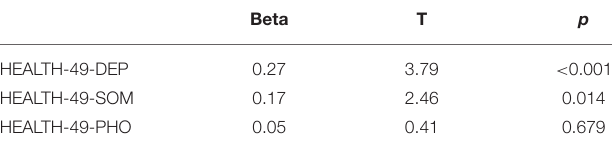
TABLE 5 | Multiple regression for prediction of TPA-SD.